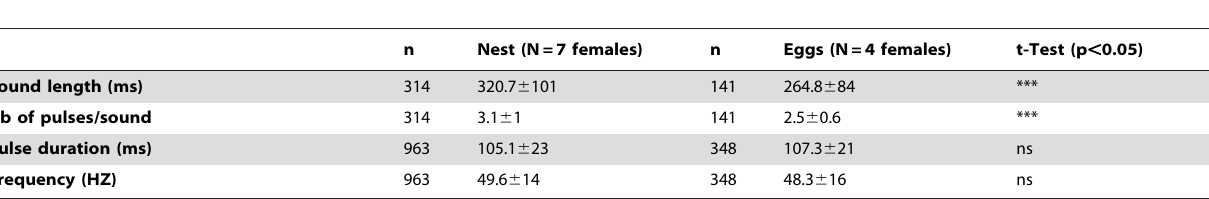
Table 7. Means ( 6 SE) of the sonic parameters of Oreochromis niloticus females, recorded in situation of territoriality (Nest) and of oral incubation